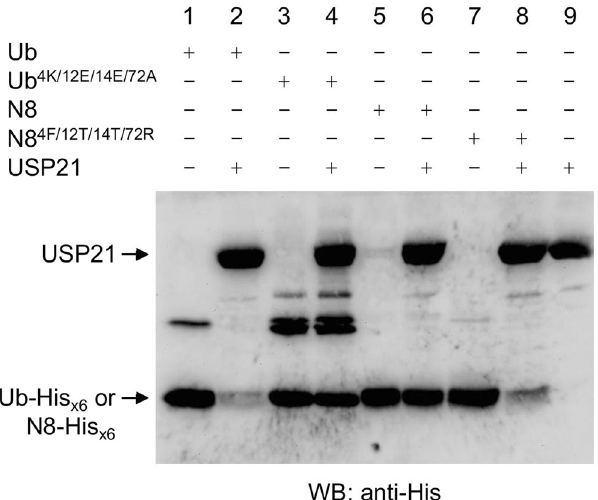
Figure 6. USP21 displayed the same substrate recognition mechanism as USP2. Ub, Ub 4K/12E/14E/72A , NEDD8, and NEDD8 4F/12T/14T/72R (13.8 μ M) were incubated with or without USP21 (4.425 μ M) at 37 °C for 60 min. Samples were separated on 16.6% SDS-PAGE and further analyzed using western blotting with the anti-His x6 tag antibody.